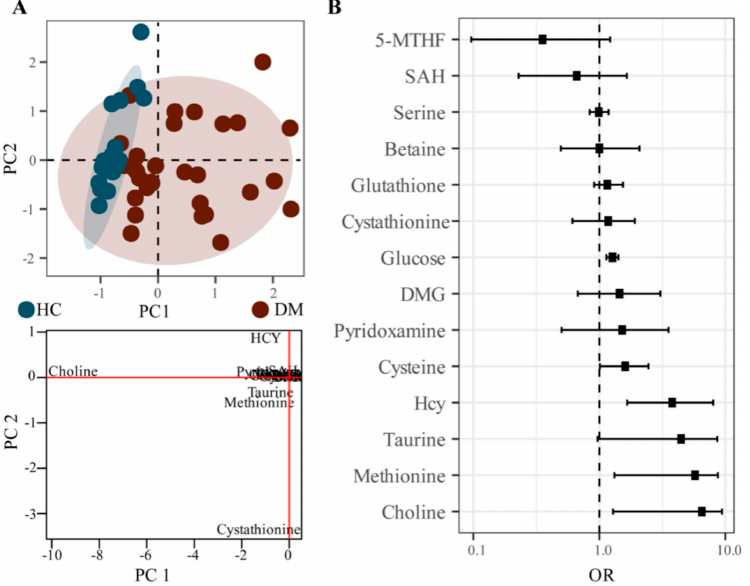
Figure 4. PPCA analysis and Poisson regression analysis of HC and DM groups. (( A ). PPCA score plot and loading plot, ( B ). OR and confidence interval distribution plot of Poisson regression anal- ysis).